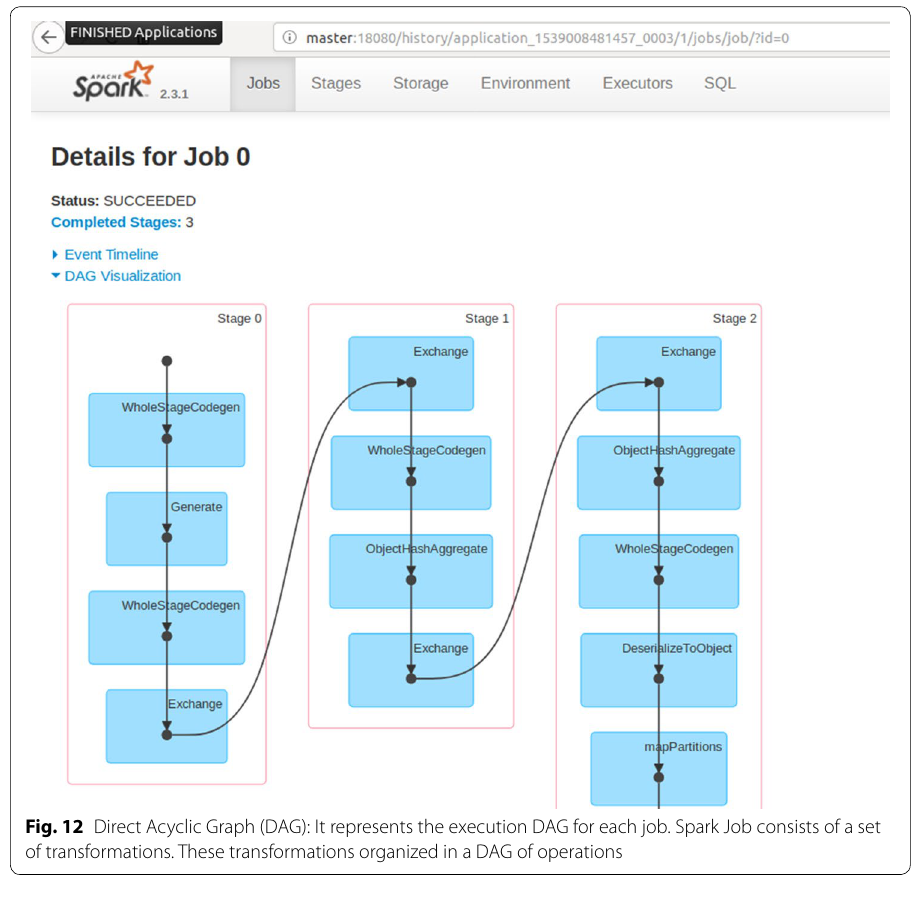
Fig. 12 Direct Acyclic Graph (DAG): It represents the execution DAG for each job. Spark Job consists of a set of transformations. These transformations organized in a DAG of operations